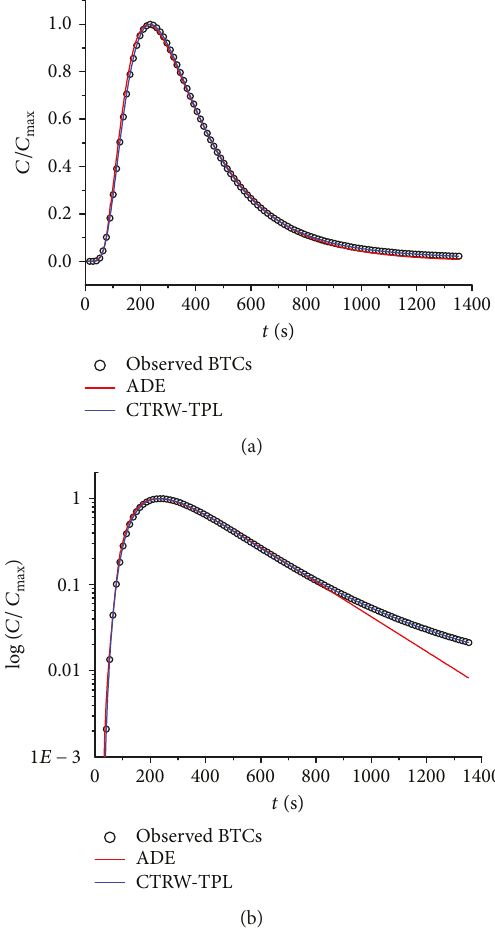
Figure 6: Comparison of fi tted line of ADE and TPL when v = 5 0 × 10 − 2 m/s : (a) normal coordinate system; (b) semilog scale coordinate